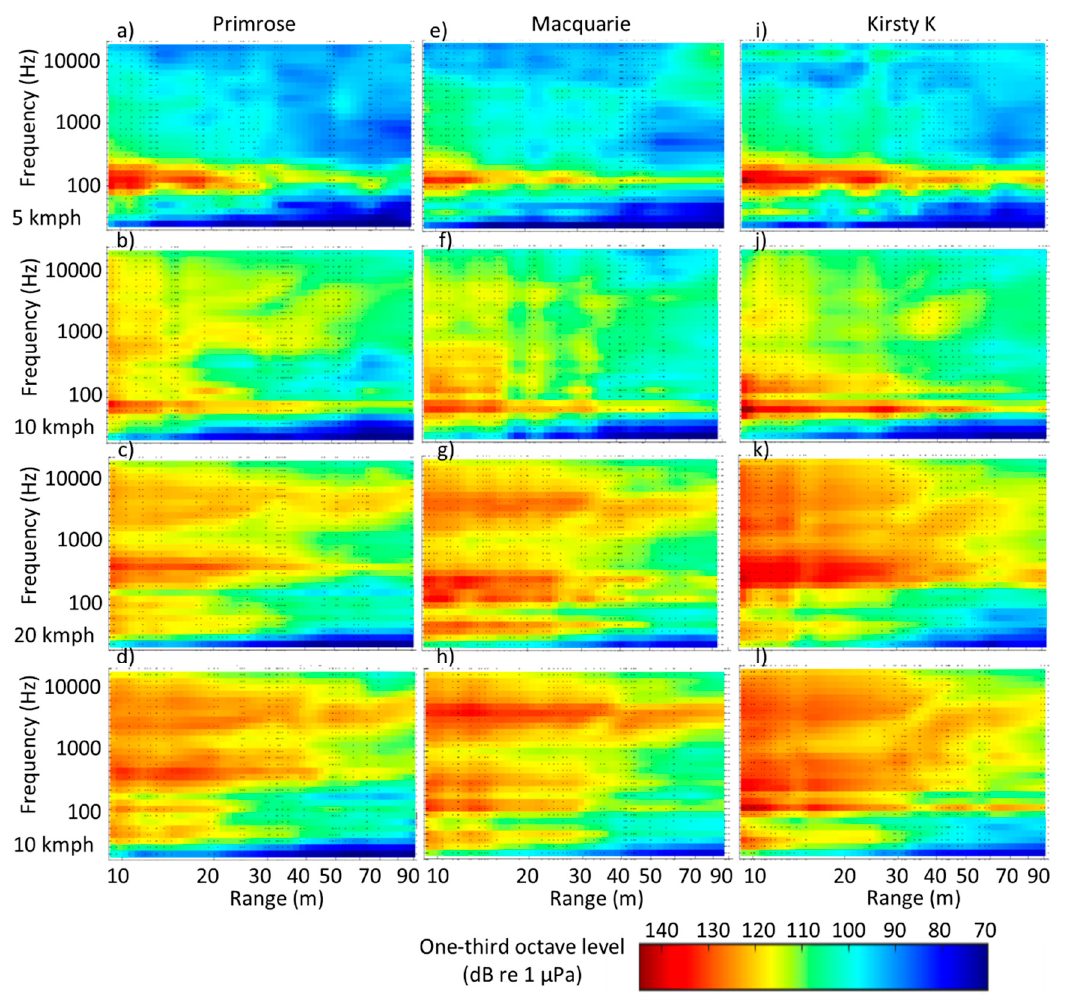
Figure 6. Interpolated (in log frequency and log range bins) one-third octave band received levels with range for each vessel ( a – d , Primrose ; e – h , Macquarie ; i – l , Kirsty K ), at each speed. ( a , e , i , 5 km h − 1 ; b , f , j , 10 km h − 1 ; c , g , k , 20 km h − 1 ; d , h , l , 30 km h − 1 ). Black dots show the ranges at which measurements were taken to highlight gaps in interpolated data.